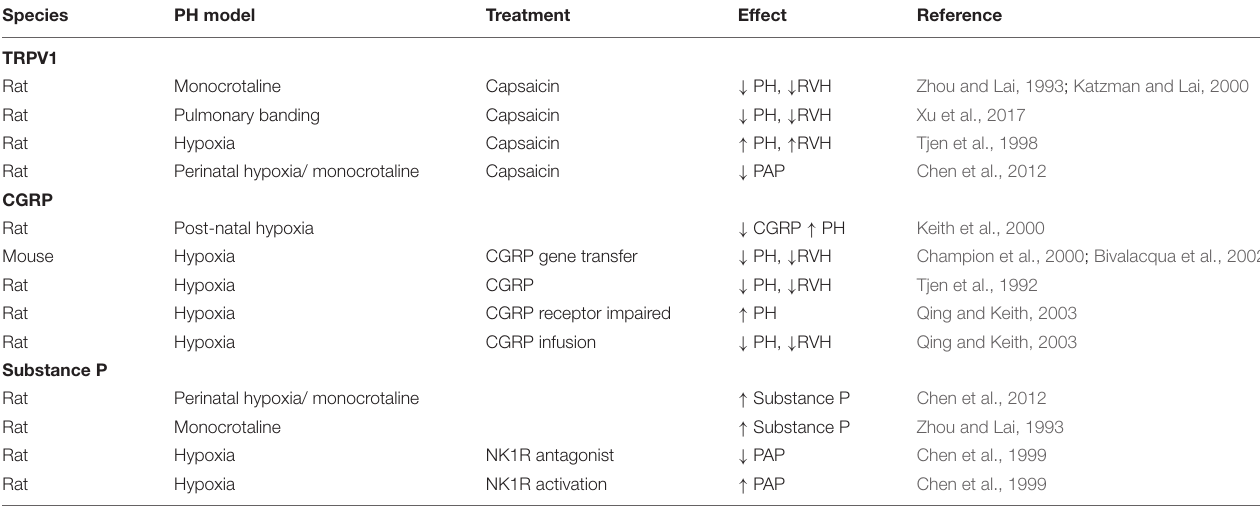
TABLE 1 | Role of neuropeptides in experimental models of PH. Species